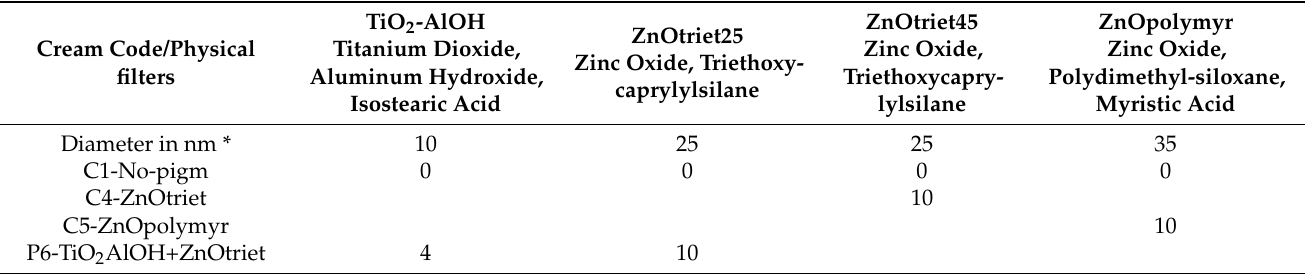
Table 1. Cream formulations codes with implemented physical filters in % and the size of the physical